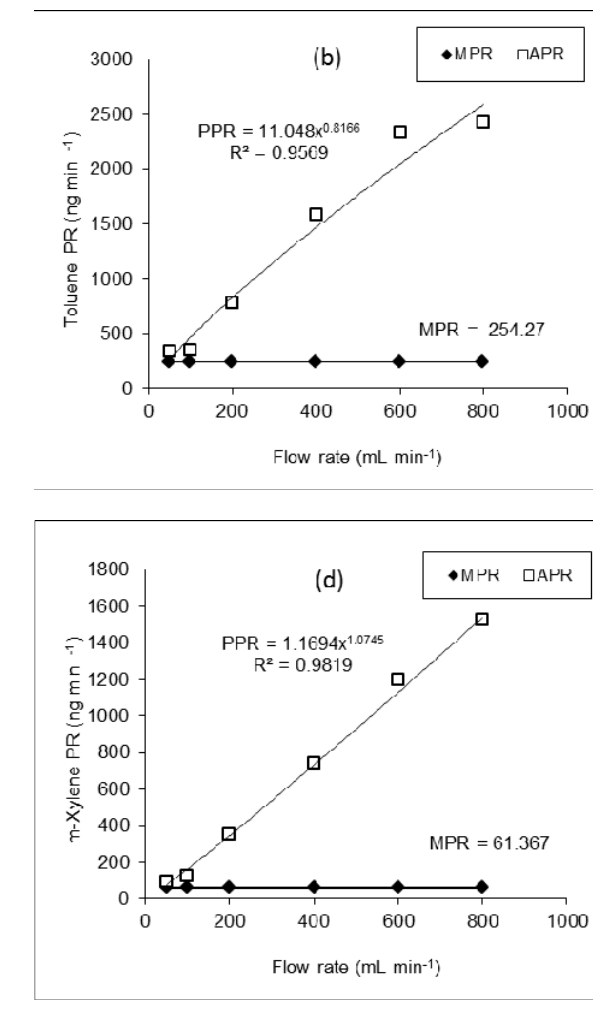
Figure 3. Dynamic relationship between the measured permeation rate (PR: ng·min − 1 ) and flow rates (FR: mL·min − 1 ) of dilution gas by using impinger system. Labels: MPR = manufacturer given PR; APR = actual measured PR; and PPR = predicted PR using our developed